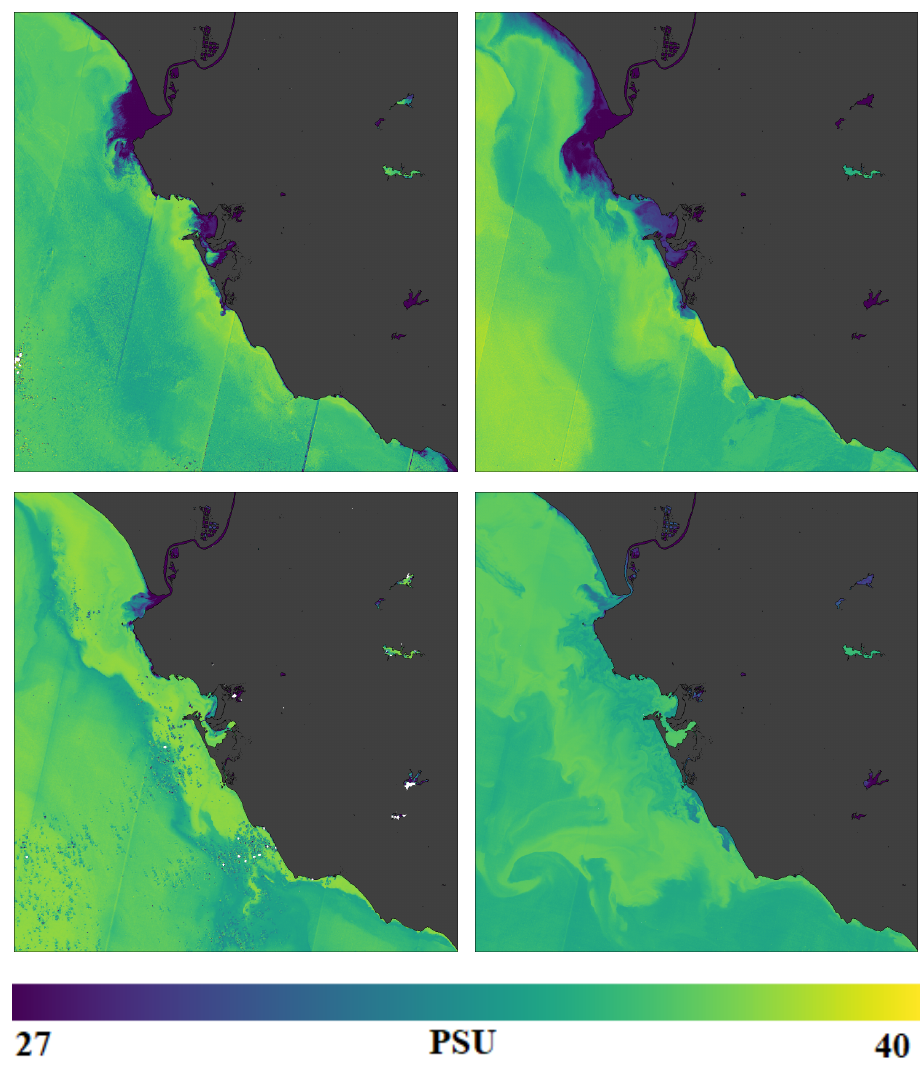
Figure 14. Evaluation of neural network: salinity prediction at the mouth of the Guadalquivir River during 2016 in May ( top left ), August ( top right ), October ( bottom left ) and December ( bottom right ). Units of salinity are